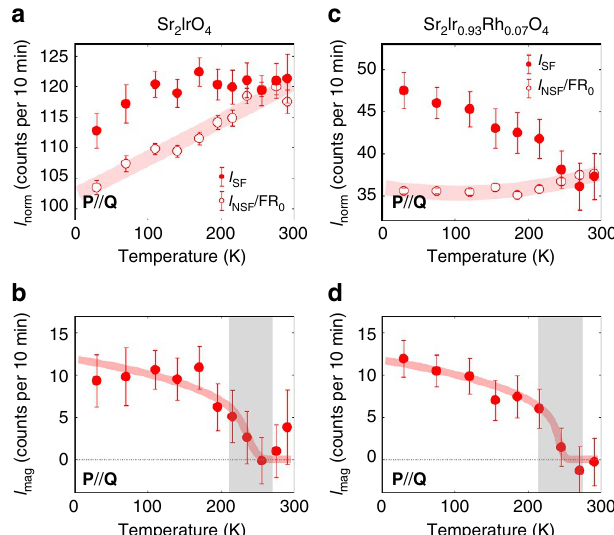
Figure 3 | Hidden magnetic order in Sr 2 Ir 1 (cid:2) x Rh x O 4 . ( a , c ) Temperature I NSF /FR 0 ( T ) from the dependence of I SF and a bare SF intensity I 0 SF ¼ polarization leakage. The temperature-dependent bare flipping ratio FR 0 ( T ) is taken from the reference Bragg peak (2, 2, 0) and rescaled to correct the NSF intensity at (1, 1, 2) (see Supplementary Note 2). ( b , d ) Temperature dependence of the magnetic intensity I mag ¼ I SF (cid:2) I NSF /FR 0 ( T ) at the nuclear Bragg peak (1, 1, 2). Red curves are a guide to the eye and grey areas represent temperature uncertainty in the determination of T mag